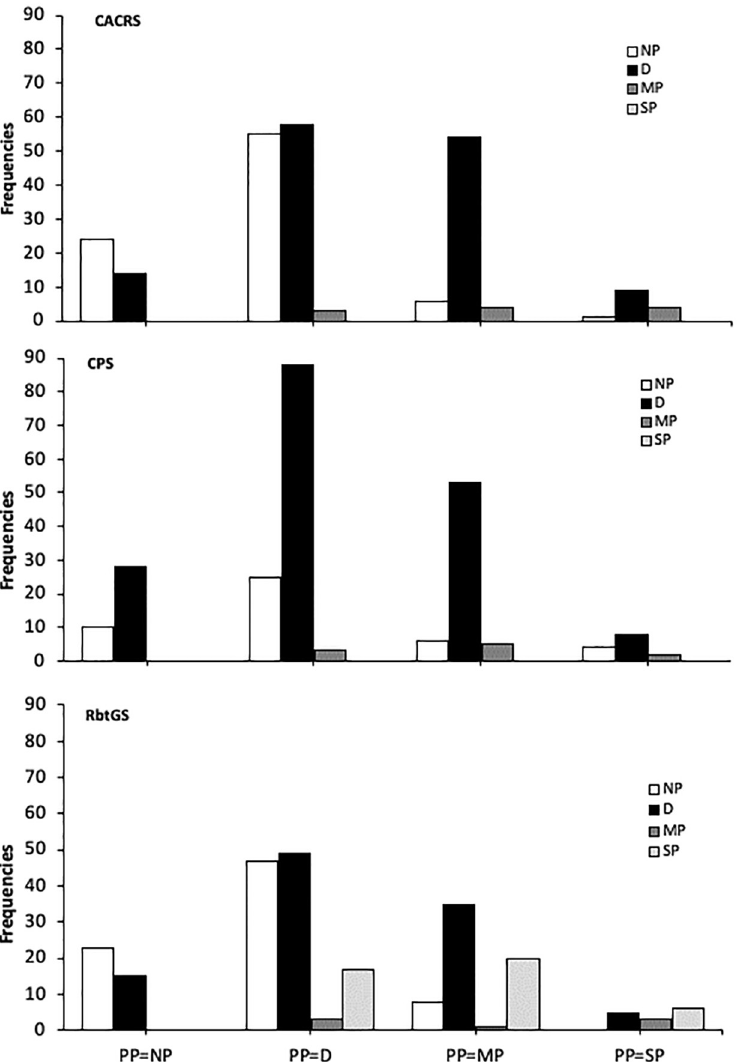
Fig 1. Distribution of the results obtained using CANCRS, CPS, and RbtGS related to presumptive pain classes (PP). CANCRS: results show that frequencies are not randomly obtained, but diagnosis obtained by assessing pain with the CANCRS are related to PP (p � 0.05). CPS: results show that frequencies could be randomly obtained, and that there is no relation between CPS and PP (p > 0.005). RbtGS: results show that frequencies are not randomly obtained, but diagnosis obtained by assessing pain with the RbtGS are related to PP (p �